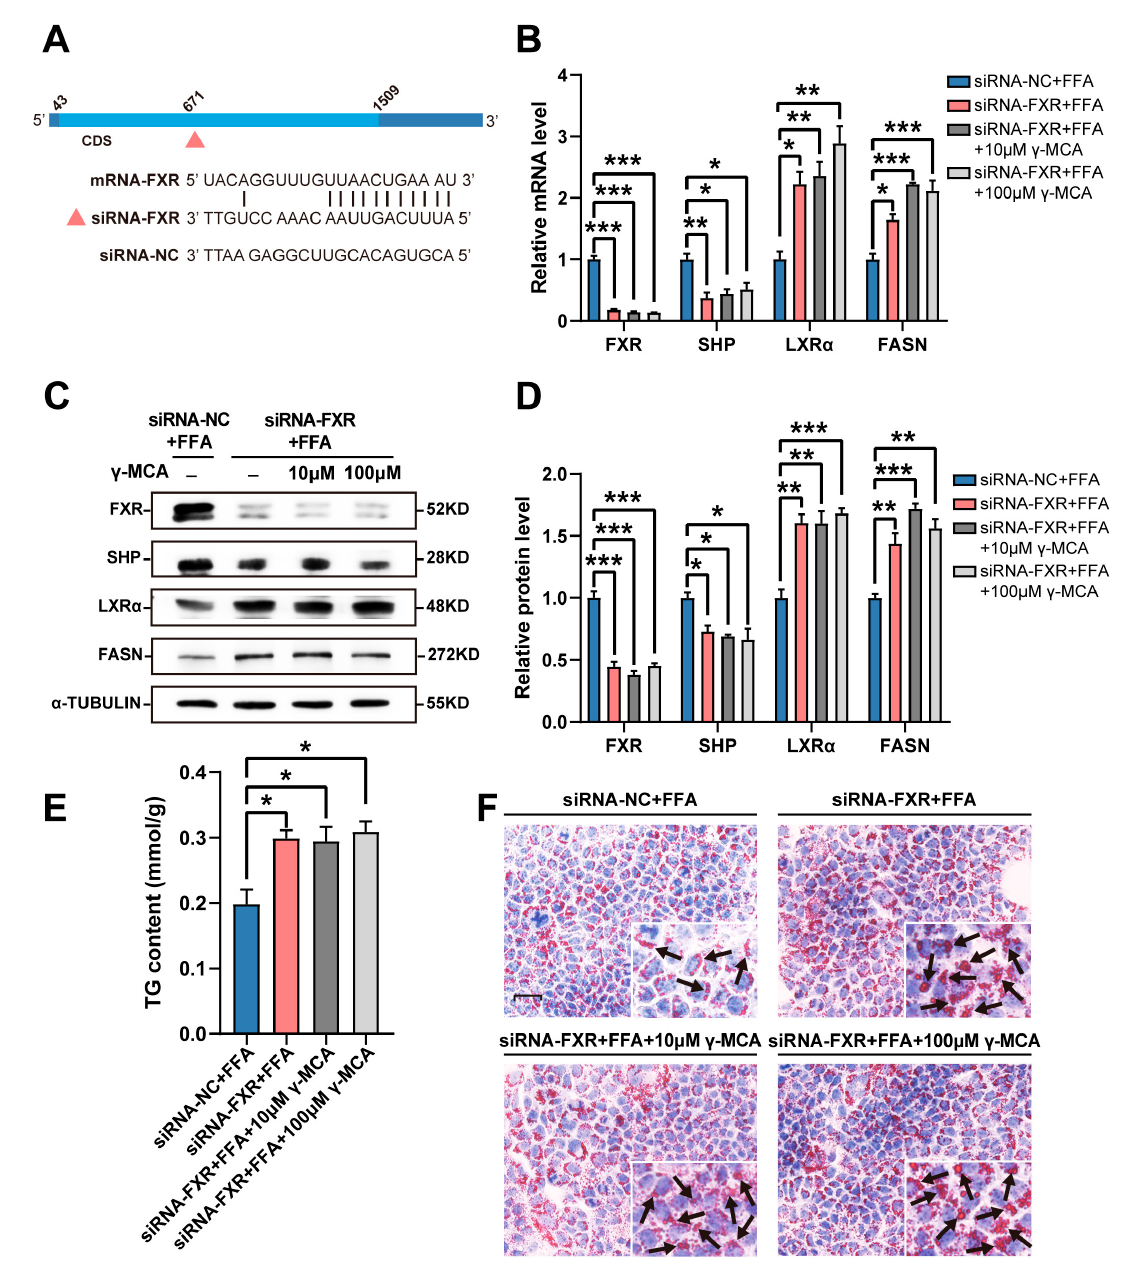
Figure 2. FXR deficiency abolished the inhibitory effect of γ -MCA on hepatocellular steatosis. ( A ) siRNA-FXR, but not the negative control (siRNA-NC), targeted FXR mRNA by base complemen- tation. ( B ) siRNA-FXR degraded FXR mRNA and then transcriptionally deprived the activation of FXR/SHP/LXR α /FASN signaling upon γ -MCA administration. ( C , D ) Western blot ( C ) and quanti- tative analysis ( D ) exhibited the inactivation of γ -MCA-induced SHP, LXR α , and FASN expression upon the condition of FXR knockdown. ( E , F ) FXR knockdown abolished the γ -MCA-dependent downregulation of TG concentration ( E ) and hepatocellular steatosis (scale bar: 25 µ m) ( F ). Arrows indicate the lipid droplets in the cytoplasm of the hepatocytes. The data were presented as the mean ± SEM. *, p < 0.05; **, p < 0.01; and ***, p < 0.001.